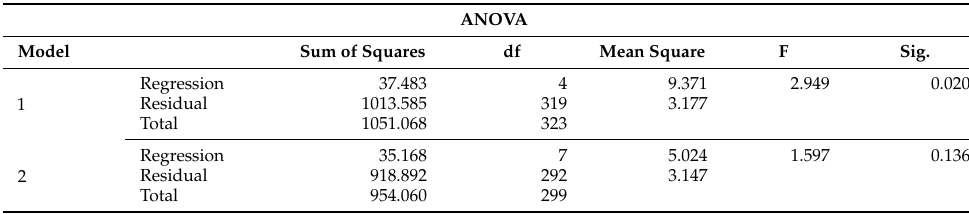
Table 4. Goodness of fit